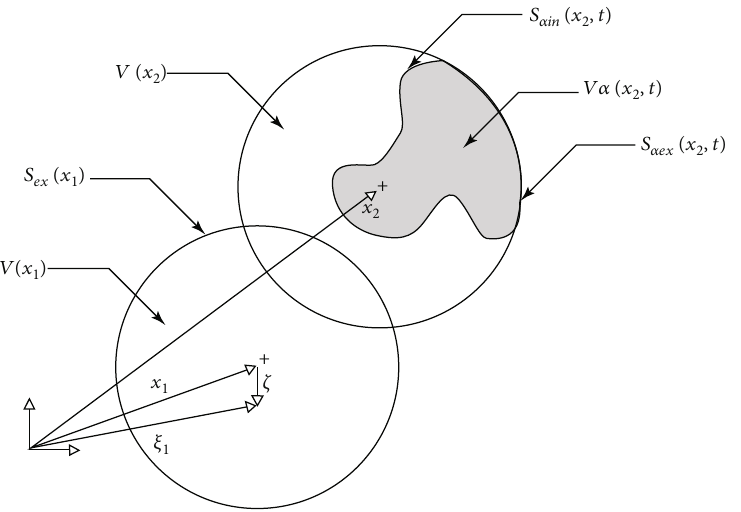
Figure 2: A two possible averaging volumes